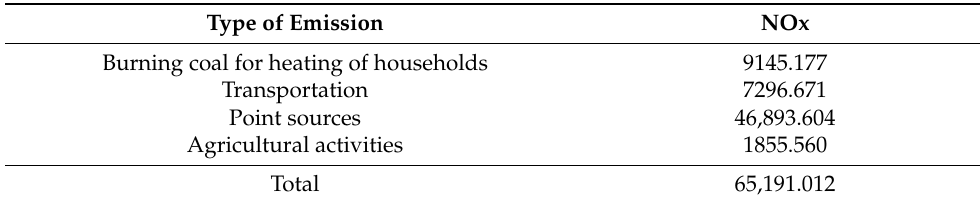
Table 7. Emission of NOx in 2015 [47].